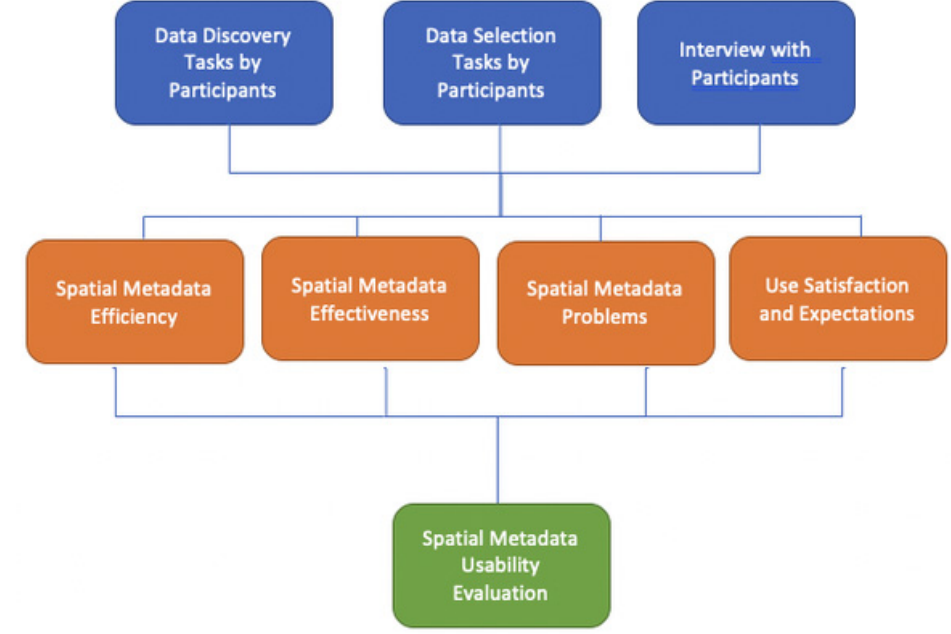
Figure 2. Diagrammatic view of experiment design.